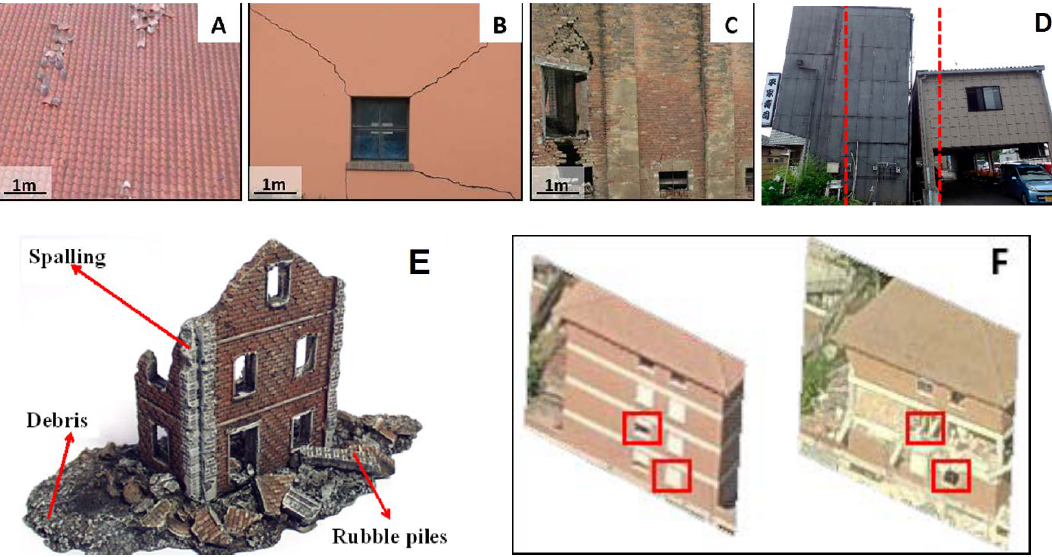
Figure 3. Examples of remote sensing-based built-up proxies. ( A ) Roof with dislocated tiles, ( B ) cracks in concrete facade, ( C ) cracks and hole in brick facade [70], ( D ) inclined building [68,70], ( E ) debris, rubble piles, spalling [82], and ( F ) facade windows symmetry